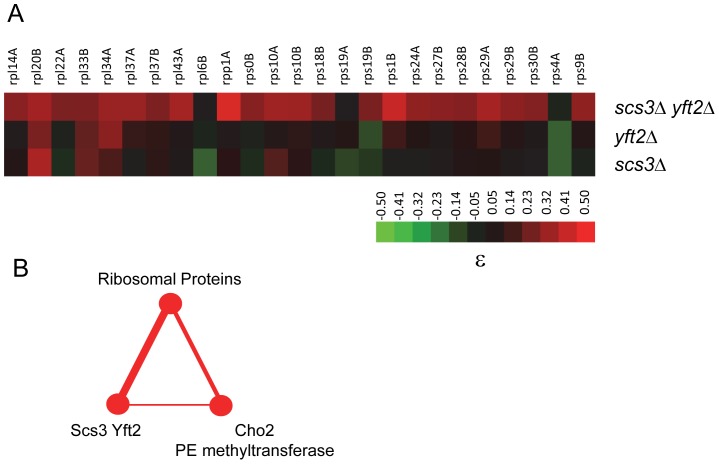
Genetic interactions of SCS3 and YFT2 linking protein and phospholipid synthesis.(A) The heat map shows ribosomal protein genes that interact genetically with deletions of SCS3, YFT2 or both genes (data were extracted from Table S1). The strength of the interactions is indicated by the colorbar. (B) Triplet genetic motif representing mutually alleviating interactions (red nodes and edges) between multiple RP genes, SCS3/YFT2 and CHO2. The thickness of the edges reflects the number of interactions. They include 25 alleviating or suppressing interactions between RP genes and SCS3/YFT2 (from panel A), five of which were also alleviating with CHO2 (i.e. RPS29B, RPS18B, RPS1B, RPL43A and RPS19B
[42]) and the interaction of SCS3/YFT2 with CHO2 (see Figure 6).